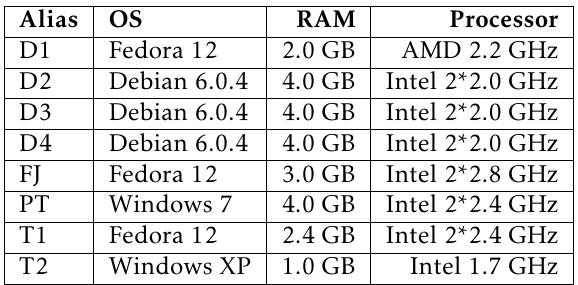
Table 2. Hardware configuration of the